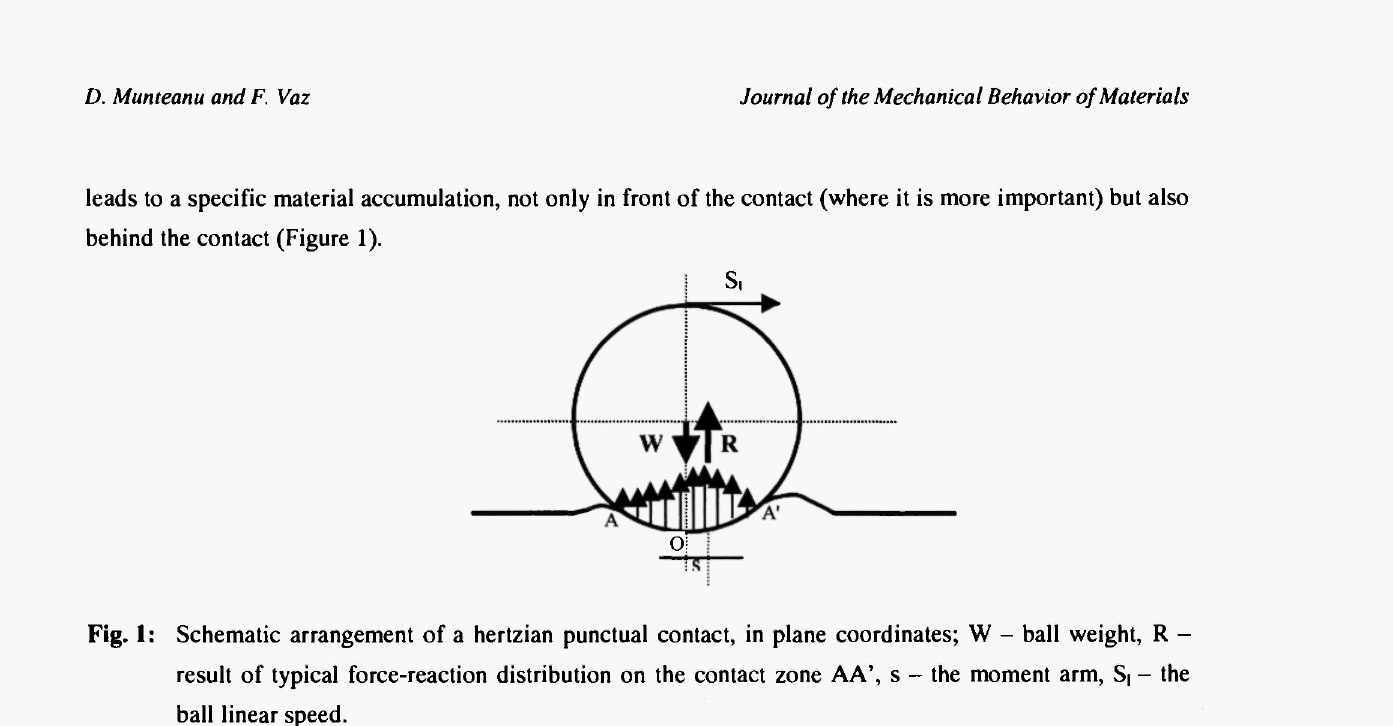
Fig. I: Schematic arrangement of a hertzian punctual contact, in plane coordinates; W - ball weight, R - result of typical force-reaction distribution on the contact zone AA\ s - the moment arm, S| - the ball linear